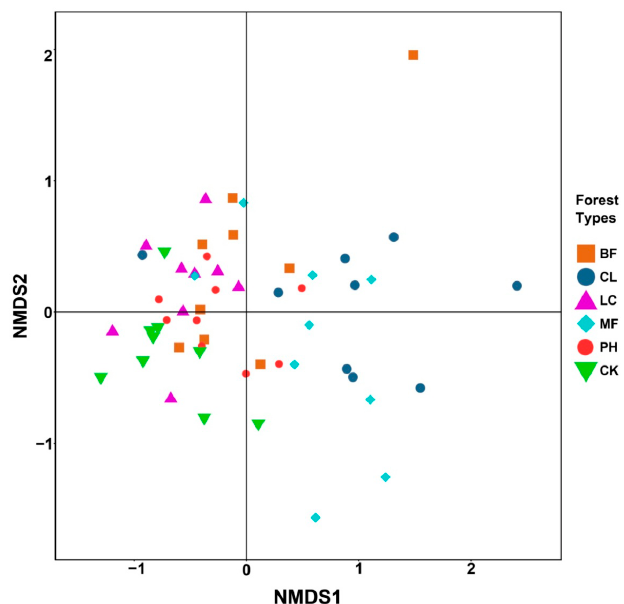
Figure 5. Nonmetric multidimensional scaling of the pairwise distances between bacterial communities as calculated using the unweighted UniFrac values. The map represents the relationships among the bacterial communities of the different forest types.